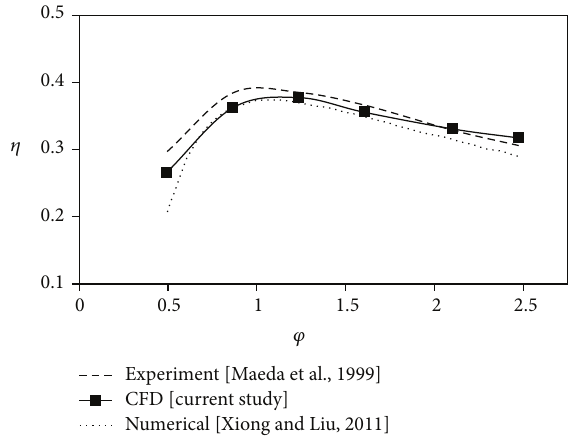
Figure 4: Validation for objective function.